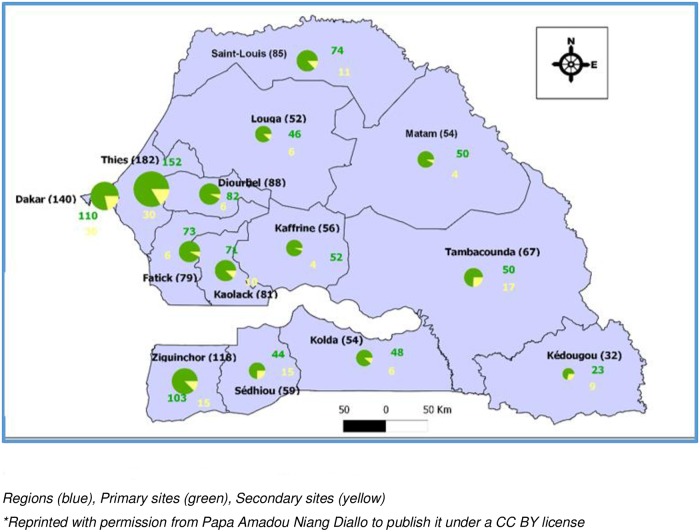
Senegalese PMTCT sites in 2015.* Cheikh Anta Diop University (CADU)/Afriqualab PT Program: is an external quality assurance/Proficiency Testing for HIV Rapid Tests, EID & Viral Load, technologies transferred by Centers for Disease Control and Prevention (CDC), Atlanta, USA.